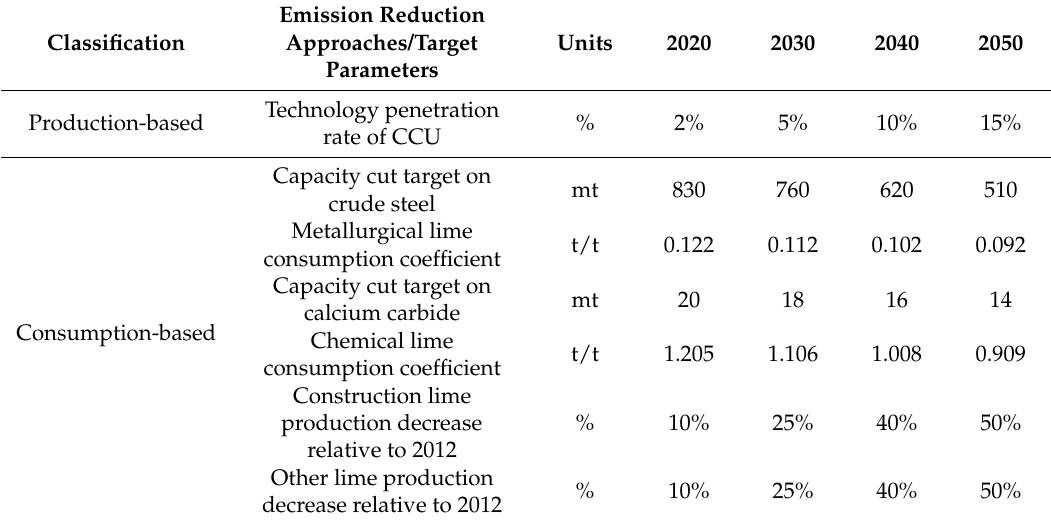
Table 3. Emission reduction approaches and target parameters under the